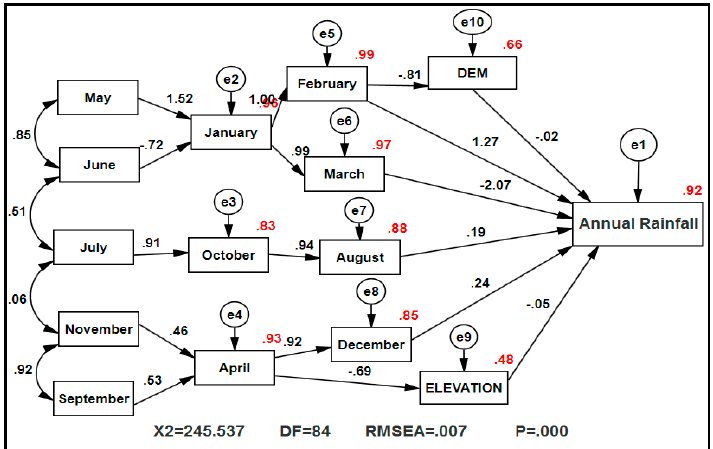
(0.48 < R 2 < 0.99, red